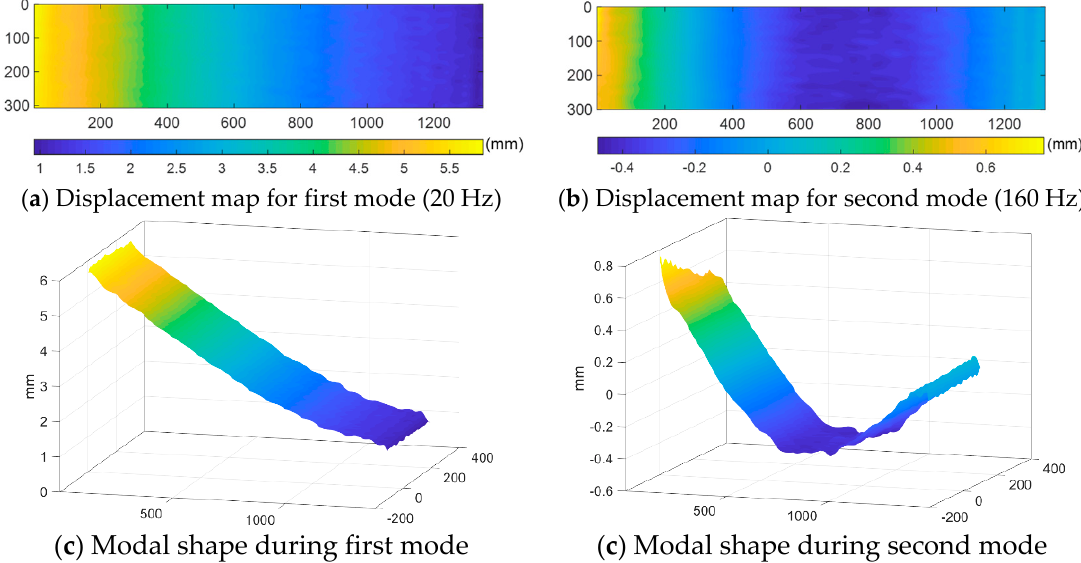
Figure 6. Modal shapes for the first and second vibration modes.